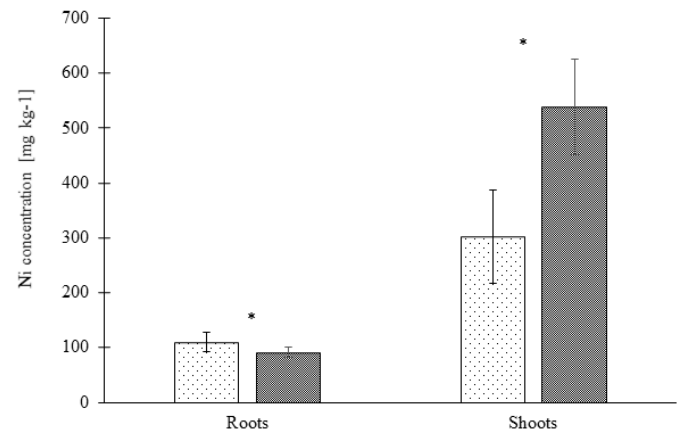
Figure 2. Nickel accumulation in shoots and roots of two Noccaea goesingensis ecotypes upon 21 days of exposure to 150 µ M Ni. Error bars represent ± SD, asterisk indicates the statistical significance of the t-test at p ≤ 0.05 (N = 3).